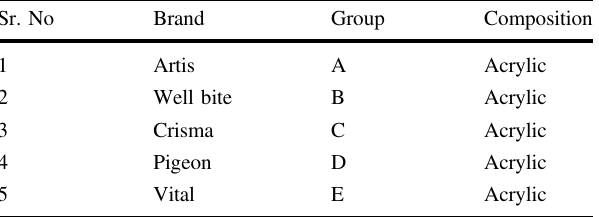
Table 1 Brands and respective groups of selected PMMA arti fi cial teeth Sr.